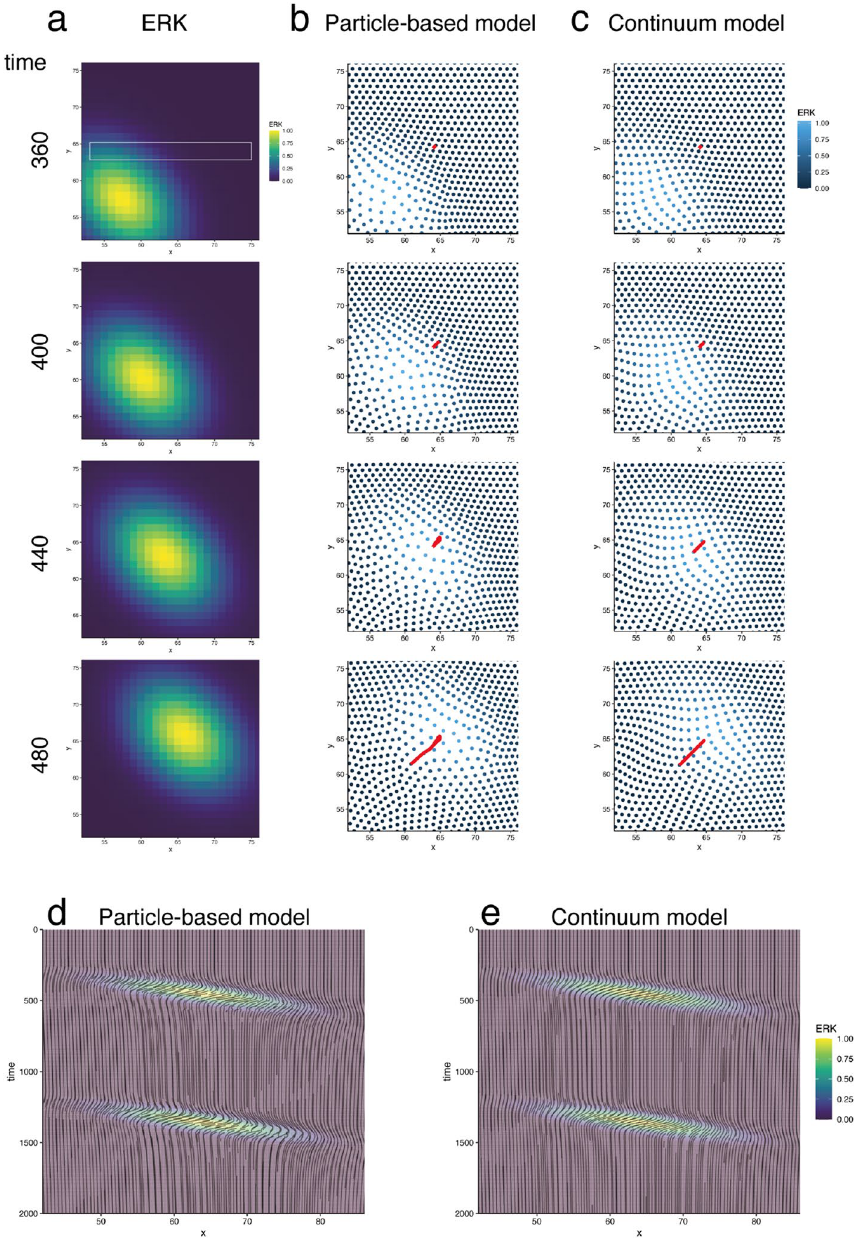
represents cells in the particle-based model ( b ) and virtual marker simulated in the Lagrange description ( c ). Red lines indicate the trajectories of the cell ( b ) and virtual marker ( c ), which are initially located at the same position. See a supplemental movie for these simulations. ( d , e ). Trajectories of the simulated cells in space ( x )— time coordinates in the particle-based ( d ) and continuum ( e ) models. Cellular migration trajectories within a white box region shown in ( a